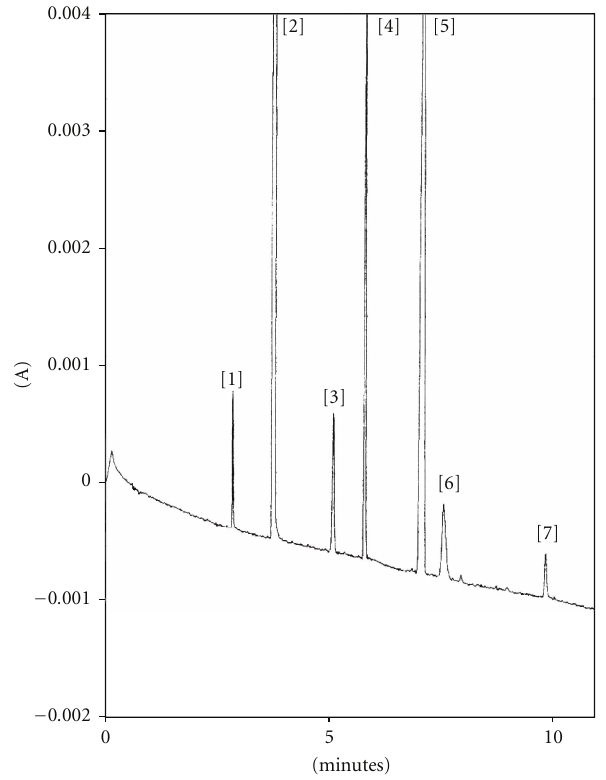
Figure 3: Electropherogram of real sample Berocca Plus. Experi- mental conditions: see Figure 2. Peak identification: (1) B 1 31 µ g/ mL; (2) B 3 36 µ g/mL; (3) B 2 35 µ g/mL; (4) B 6 40 µ g/mL; (5) as- corbic acid (not determined); (6) B 9 5 µ g/mL; (7) SI 3 µ g/mL. The concentrations are the nominal values.